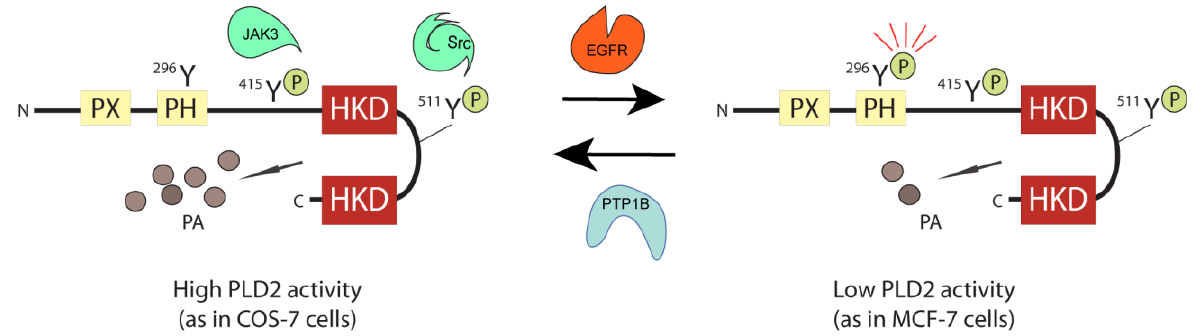
FIGURE 2. A new model highlighting the regulation of PLD2 by phosphorylation-dephosphorylation and its implication in low-activity cancer cells. Phosphorylation of Y 415 and Y 511 are essential for activity and are mediated by JAK3 and Src, respectively. Conversely, phosphorylation of residue Y 296 leads to a low-activity PLD2 (making it an “inhibitory” site), which is reversible by the action of PTP1B phosphatase. This has particular implications in cancer cells. PLD activity is frequently elevated in breast and other cancer cell lines, such as MDA-MB-231[118]. However, the MCF-7 cell line, derived from a less-aggressive form of breast cancer, has relatively low levels of PLD activity[119]. The Foster group has proposed that PLD induces the phenotype change from estrogen receptor positive (ER+) to estrogen receptor negative (ER–), which coincides with greater invasiveness of tumors, and that PLD is a signal for survival in serum-deprived cells[119,120,121]. In addition to this, we have proposed that a mechanism for a low-activity PLD2 to a high-activity PLD2 involves tyrosine phosphorylation of the inhibitory site Y 296 by EGFR